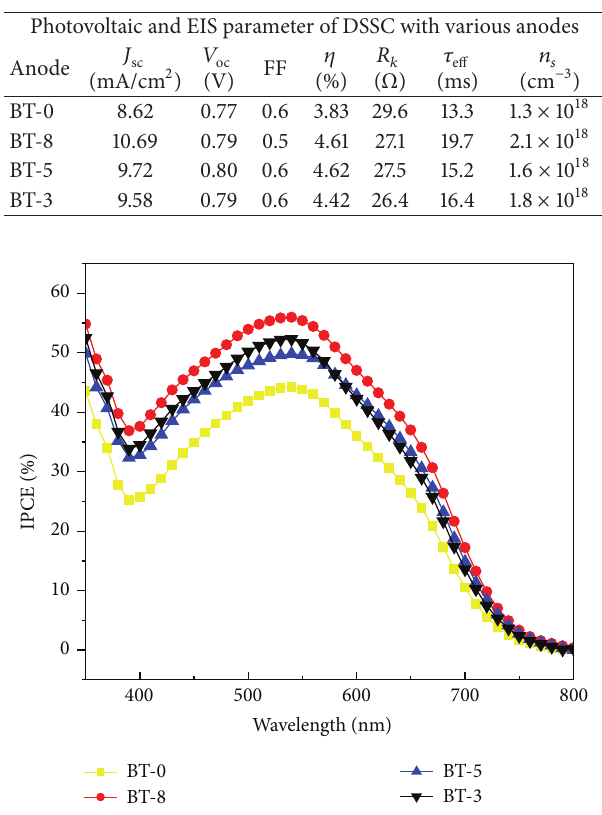
Figure 9: IPCE spectra of the dye-sensitized solar cell using mixed phase of boron-doped TiO 2 as